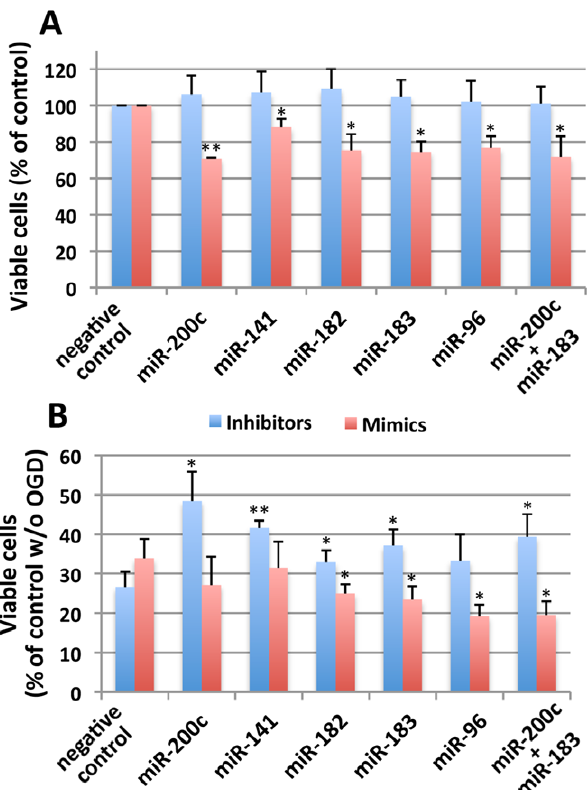
Figure 6. Effects of inhibitors and mimics for miR-200 family and miR-182 family miRNAs on OGD-induced cell death in SHSY5Y. (A) SHSY5Y cells were transfected with either inhibitors or mimics as indicated and 2days later the cell viability was measured by WST-1. Viability was expressed as percentage of negative control for either inhibitor or mimic transfected cells. (B) SHSY5Y cells transfected as mentioned above, and 2days later these cells were subjected to OGD (16 h), and viable cells were measured by WST-1. Viability was expressed as percentage of negative control cells (negative control inhibitor or negative control mimic transfected and not subjected to OGD). In both A and B, inhibitor transfected cells were shown in blue, and mimic transfected cells were shown in red. Data are shown as the mean 6 SD of three independent experiments. **p , 0.01, *p , 0.05 compared to